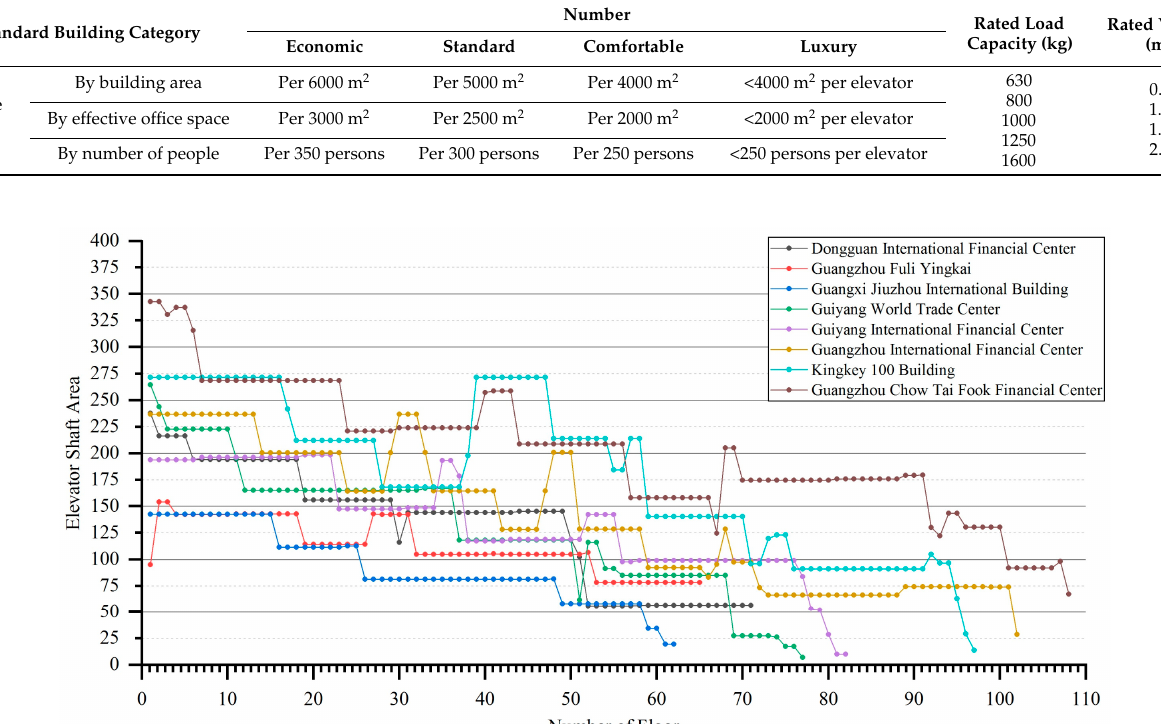
Figure 16. Schematic diagram of single and double-deck elevator system. 3.1.3. Structural Area In order to study the structural area of MUHR buildings, the structural area was divided into the peripheral column area and the core area, which facilitated the calculation of the ratio of different structural designs to the building area. The structural area of each typical floor of MUHR buildings is quite different. The structural area of the peripheral column and that of the core show the same trend, which is as follows: the higher the building, the larger the structural area. In the eight high-rise buildings, the structural area decreased with the number of floors, as shown in Figures 17 and 18. The structure not only determines the economic, rationality, and safety aspects of the building, but also directly affects the comfort of each business area in the MUHR building. In the Guangxi Jiuzhou International Building, the hotel is located in a low-zone area. The size of the peripheral column of the hotel is 700 mm, while that of the office space on the 66th floor is only 450 mm. The peripheral column affects the indoor lighting conditions of the hotel space, and the core affects the comfort of the public space. The Guangzhou International Finance Center uses a tube-in-tube system, where the outer tube is giant concrete-filled steel tubular columns with diamond-shaped oblique grids, and the inner tube is reinforced concrete. The bottom peripheral column is about 1790 mm in diameter, and it gradually decreases with the increase in height. In the design, the influence of the oblique grid outer column on the indoor lighting condition of different business types needs to be fully considered. Moreover, when designing the night lighting effect of the outer column, it is necessary to consider its impacts on the hotel guests, as detailed in Table 7 and shown in Figure 19.